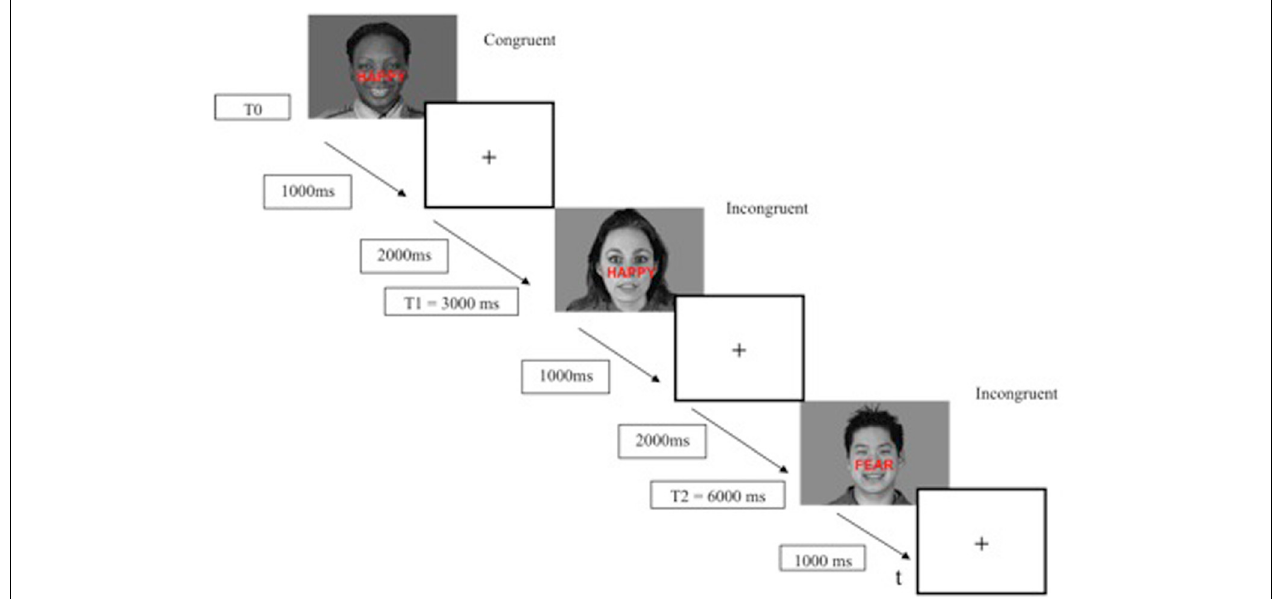
FIGURE 2 | Example timeline used in the modified emotional Stroop task fMRI